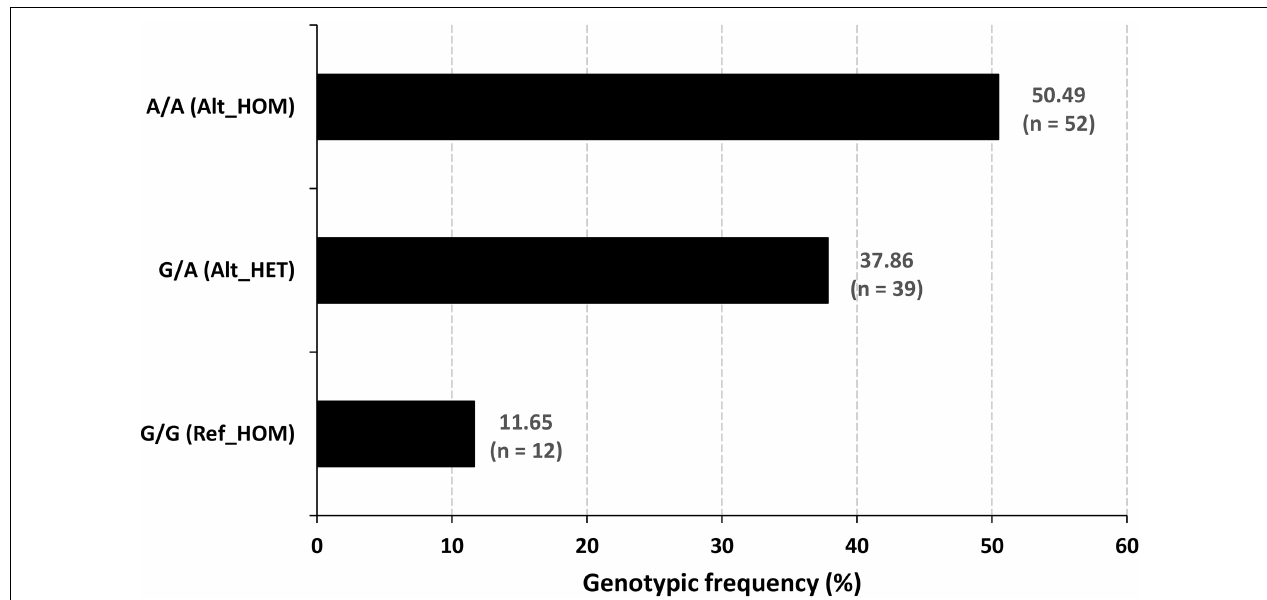
FIGURE 4 | Genotypic frequency of the OTOF variant. The mutated homozygotes were the ( n = 52) cases, and the normal hearing people were the reference homozygotes ( n = 12) and heterozygous carrier ( n = 39)